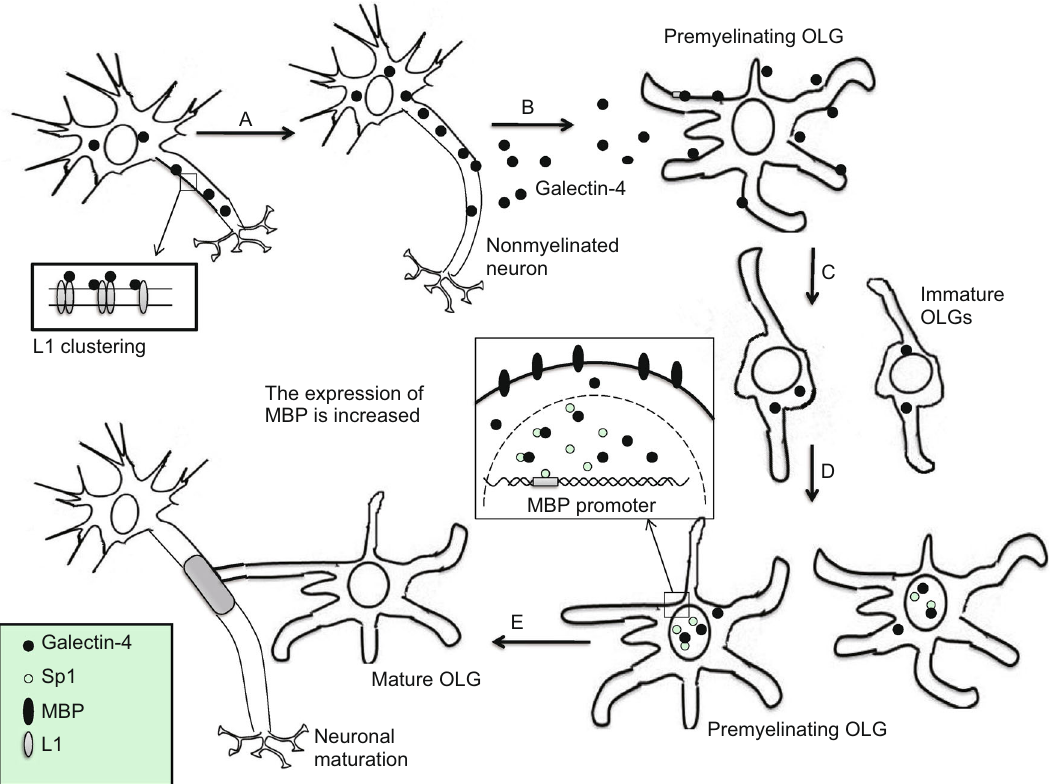
Figure 2. Galectin-4 promotes growth of axon and myelination in neuron. (A) Galectin-4 promotes outgrowth of axon through promoting L1 clustering. (B) Galectin-4 is released by nonmyelinated neurons and binds to the cell surface receptors that expressed by premyelinating OLGs. (C) Galectin-4 inhibits OLGs maturation and promotes OLGs dedifferentiation along with proliferation. (D) Immature OLGs start to differentiate. Once galectin-4 binding to the glycosylated Sp1, the stability and possibility nuclear localization of Sp1 would be increased, then leading to the upregulation of MBP gene expression. (E) Mature OLGs make the formation of myelin sheath by wrapping axons with their own cell membrane in a spiral